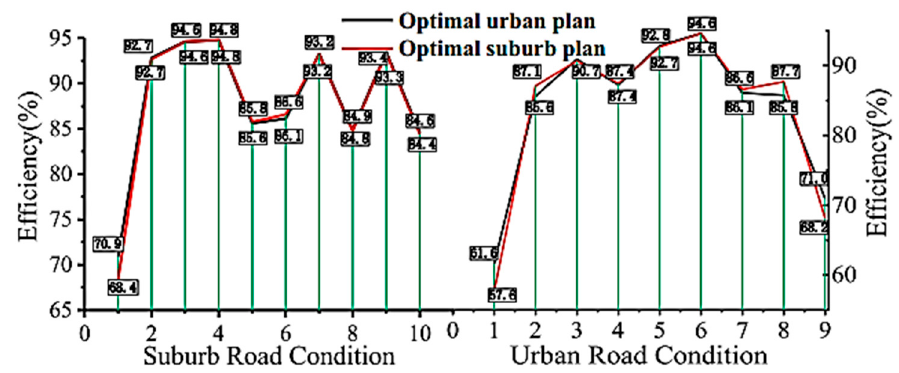
Figure 31. Comparison of motor efficiency of the optimized scheme.